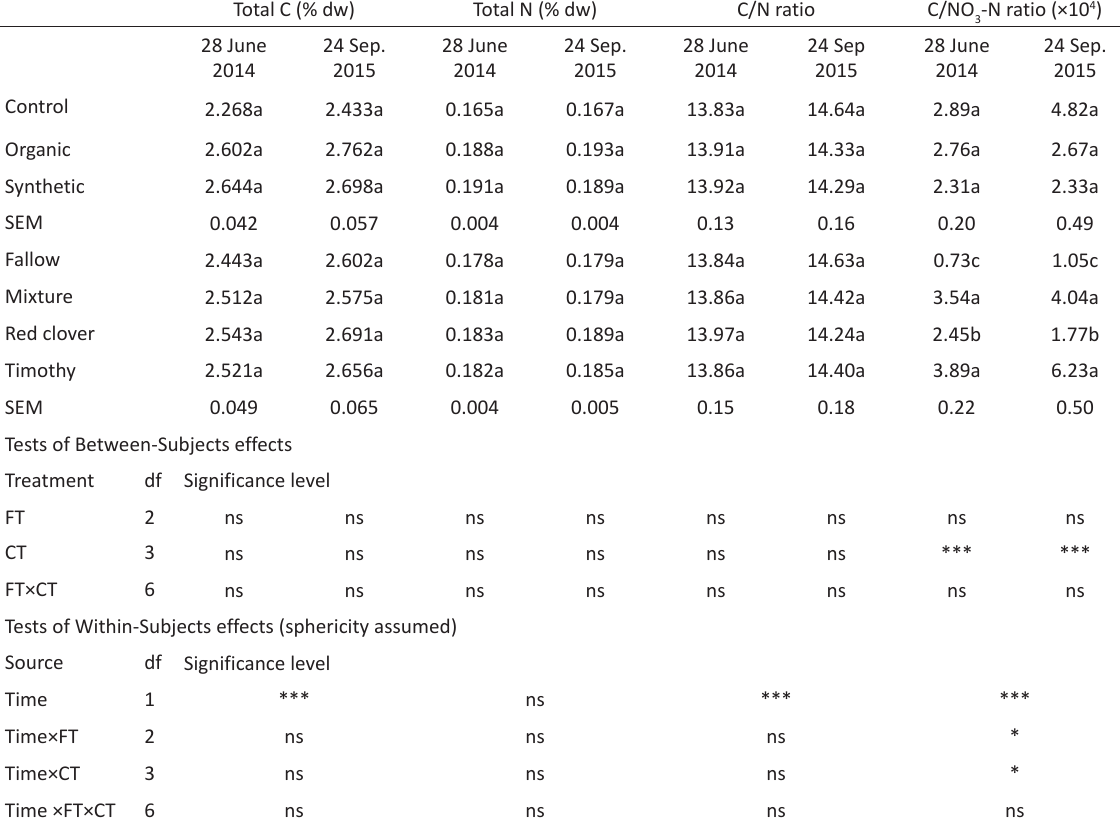
-N ratio under different fertilizer and crop 3